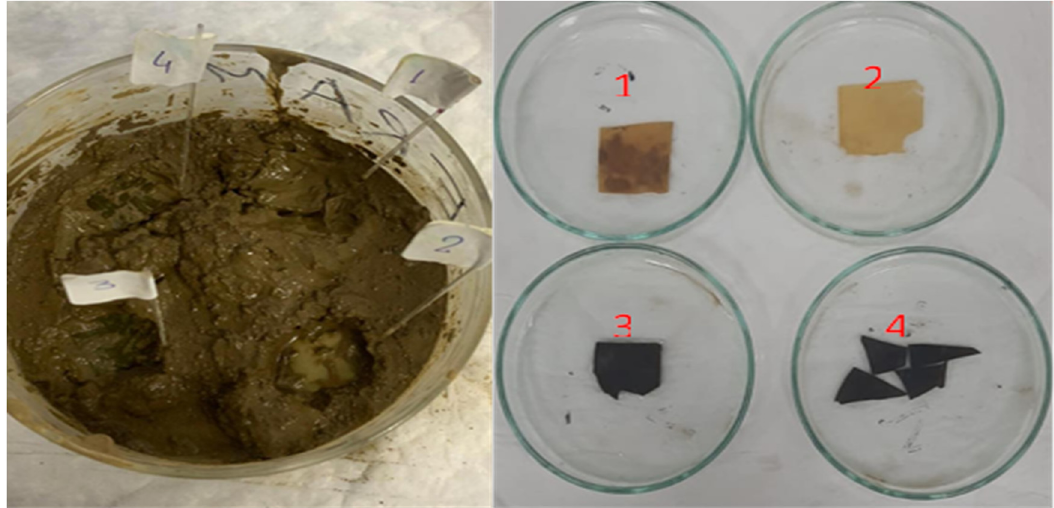
Figure 8: Soil biodegradation